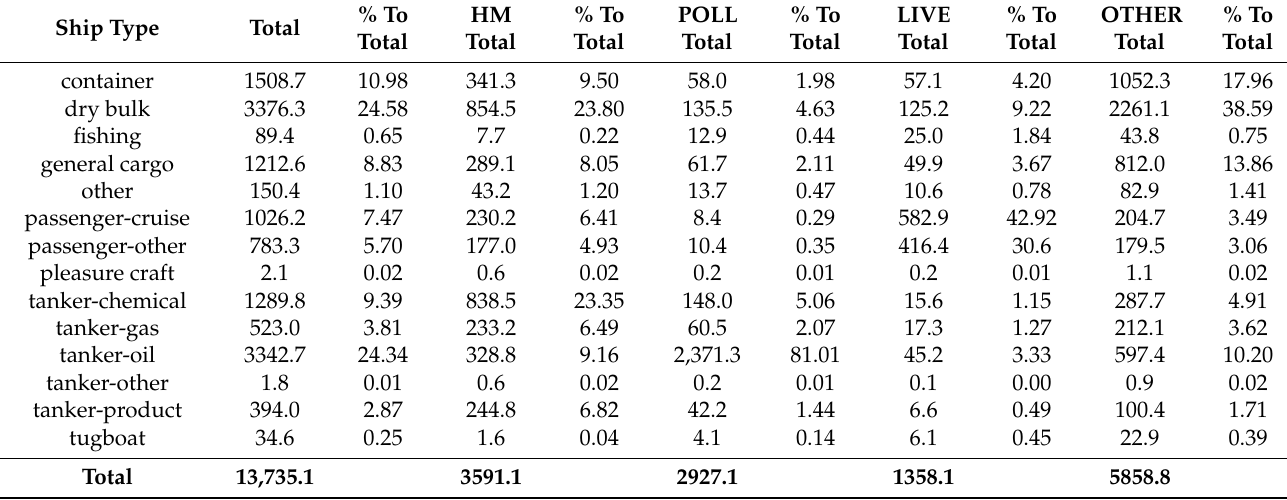
Table 3. MVR (TLVSS) by ship-type and damage-type category (2017–2020 yearly mean), in million